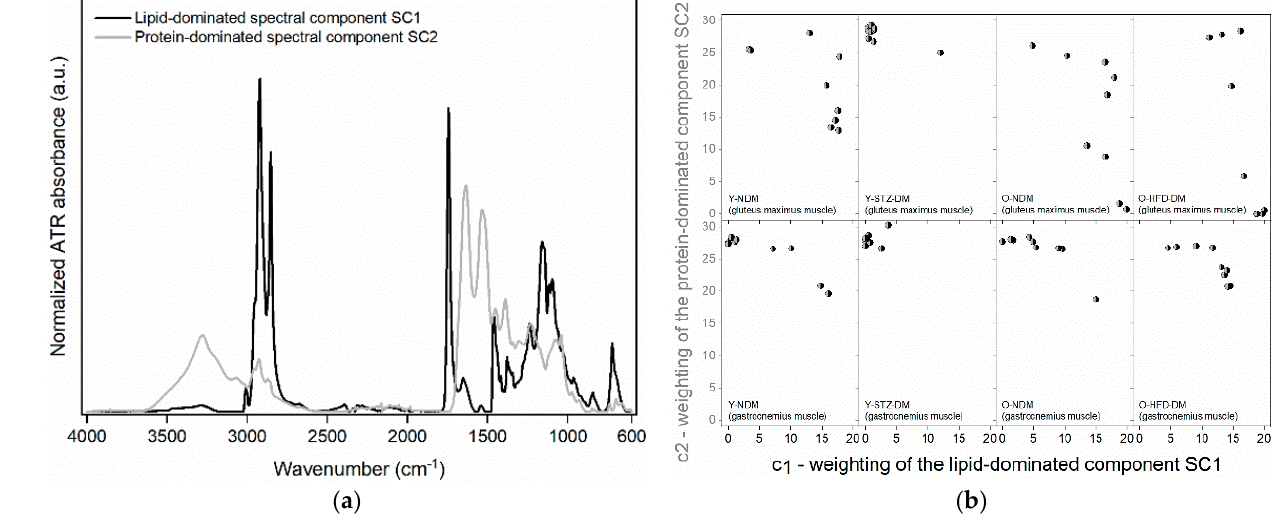
Figure 3. Two spectral components, SC 1 and SC 2, from the MCR decomposition ( a ) and the corresponding weights, c 1 and c 2, for the two spectral components obtained for gluteus maximus and gastrocnemius muscles ( b ) of 13-week-old non-diabetic mice ( n = 9) (Y-NDM), 13-week-old STZ-induced diabetic mice ( n = 9) (Y-STZ-DM), 54-week-old non-diabetic mice ( n = 9) (O-NDM), and 54-week-old HFD-induced obese insulin-resistant mice ( n = 9) (O-HFD-DM).